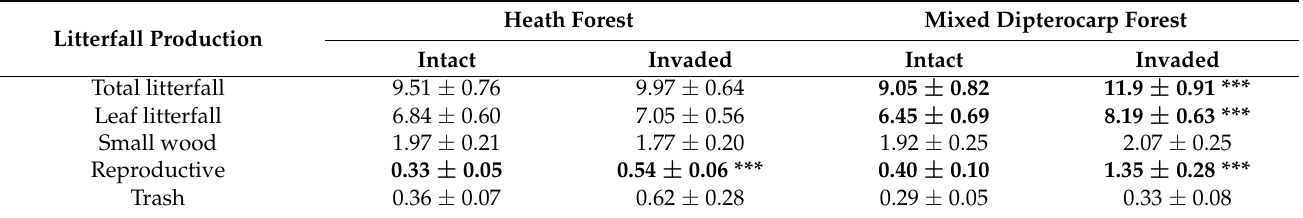
Table 1. Estimated dry masses of mean litterfall production (total litterfall, leaf litterfall, small wood, reproductive and trash) expressed in t ha − 1 yr − 1 from 24 litterfall traps in four habitat types (intact and Acacia -invaded heath forest, and intact and Acacia -invaded mixed dipterocarp forest) over